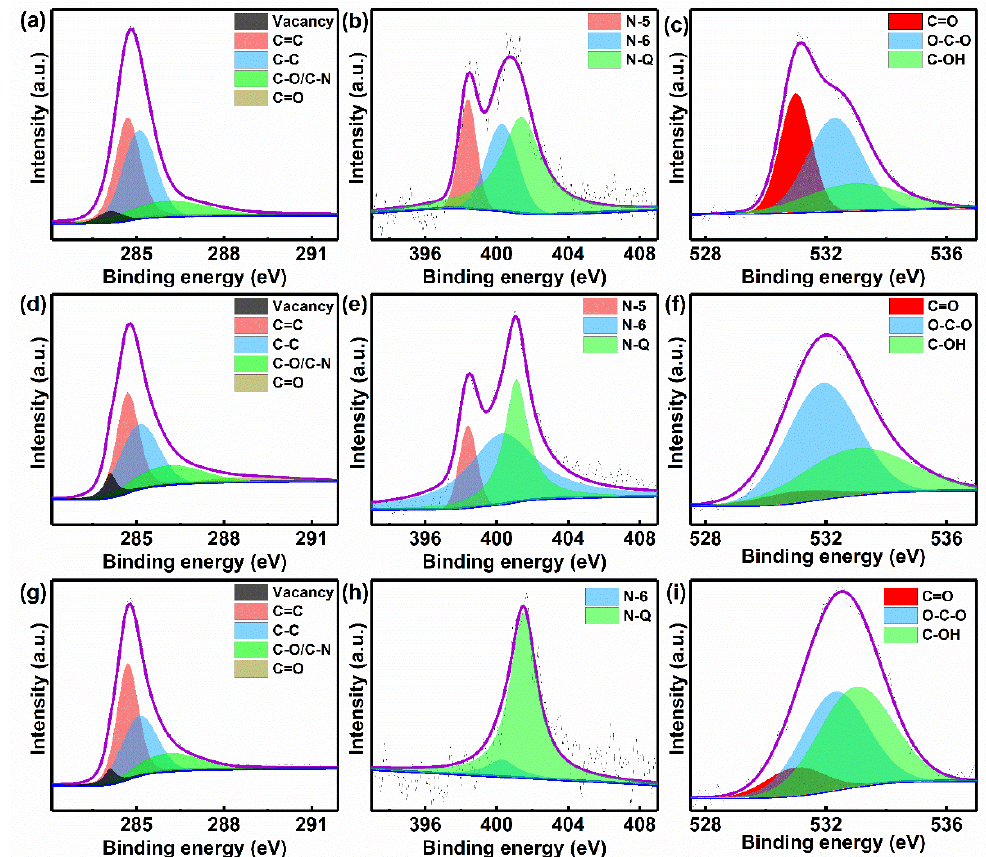
Figure 5. (( a , d , g ) C 1s, ( b , e , h ) N 1s and ( c,f,i ) O 1s of ( a – c ) NPCNSs-900, ( d – f ) NPCNSs-1000, and ( g – i ) NPCNSs-1100.